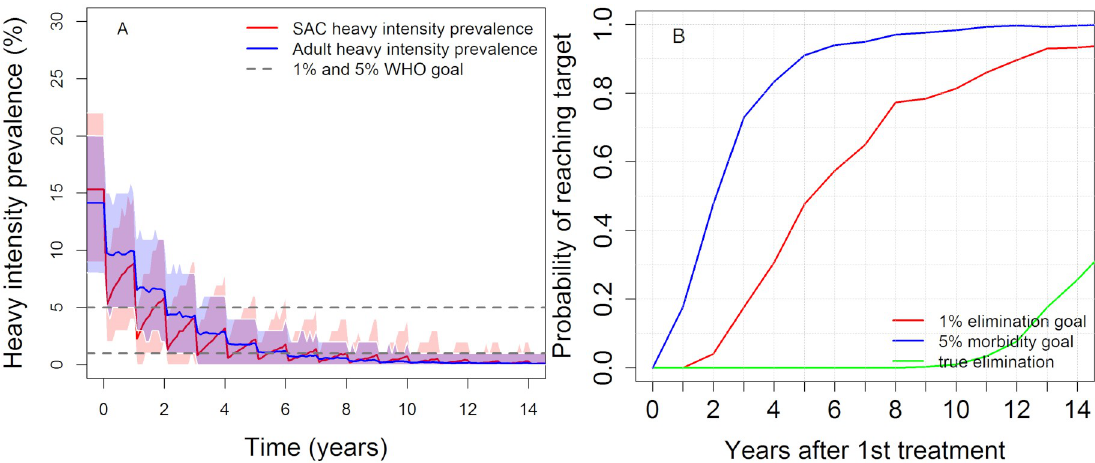
Fig 3. Model projections of annual MDA treatment of 85% school-aged children (SAC; 5–14 years of age) and 40% adults (15+ years of age). Shown for high prevalence settings ( � 50% SAC baseline prevalence). The shaded areas (both blue and red) represent the 90% credible interval. Graph (A) shows the prevalence of heavy-intensity infections in school-aged children (SAC) and adults. Graph (B) represents the probability of reaching the WHO goals by year